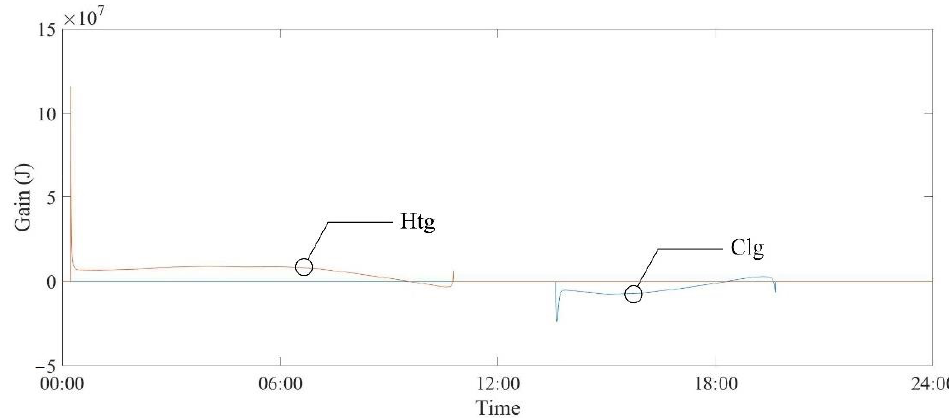
Figure 11. Energy consumption controlled by NC.